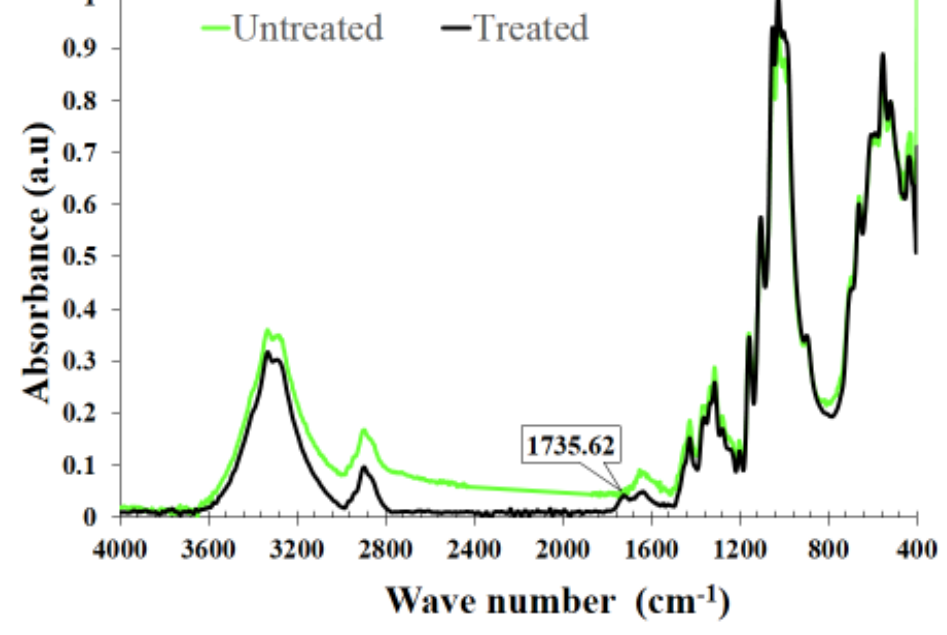
Figure 10. FT-IR spectra of treated and untreated cotton fabric.